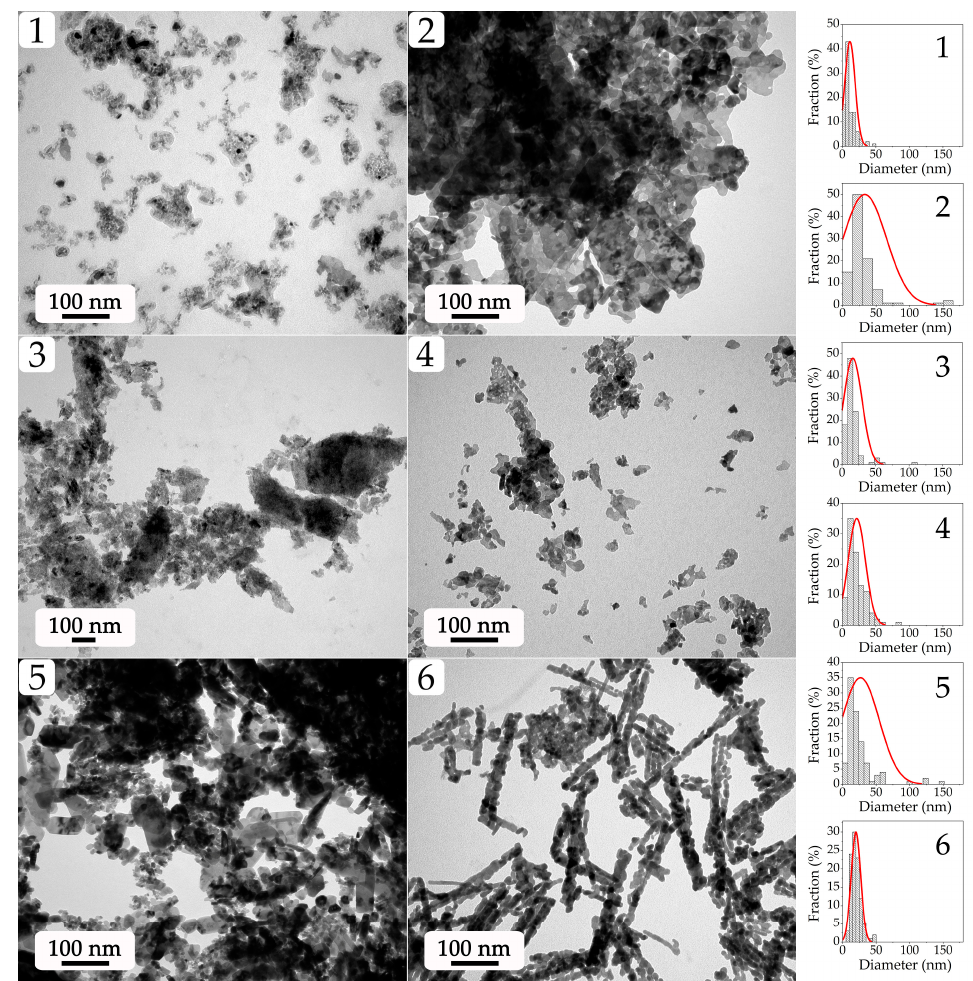
Figure 5. Microstructure of the obtained NiO nanopowders (samples 1–6; according to the TEM data) and the corresponding particle size distributions (right column).